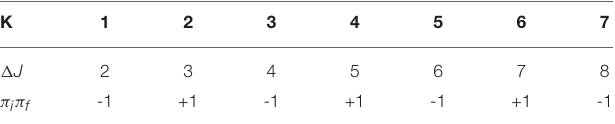
TABLE 3 | The change in angular momentum and parity in a Kth forbidden unique β decay. K